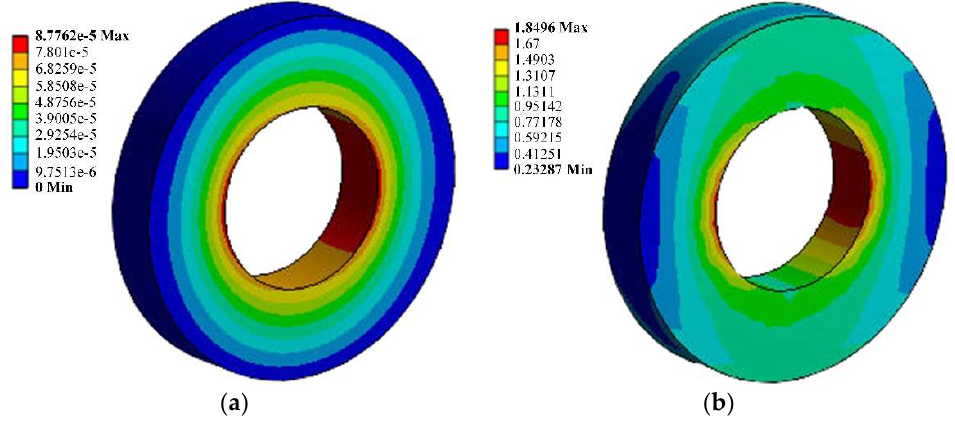
Figure 5. Numerical results of rigid support: ( a ) Stiffness; ( b ) Stress.